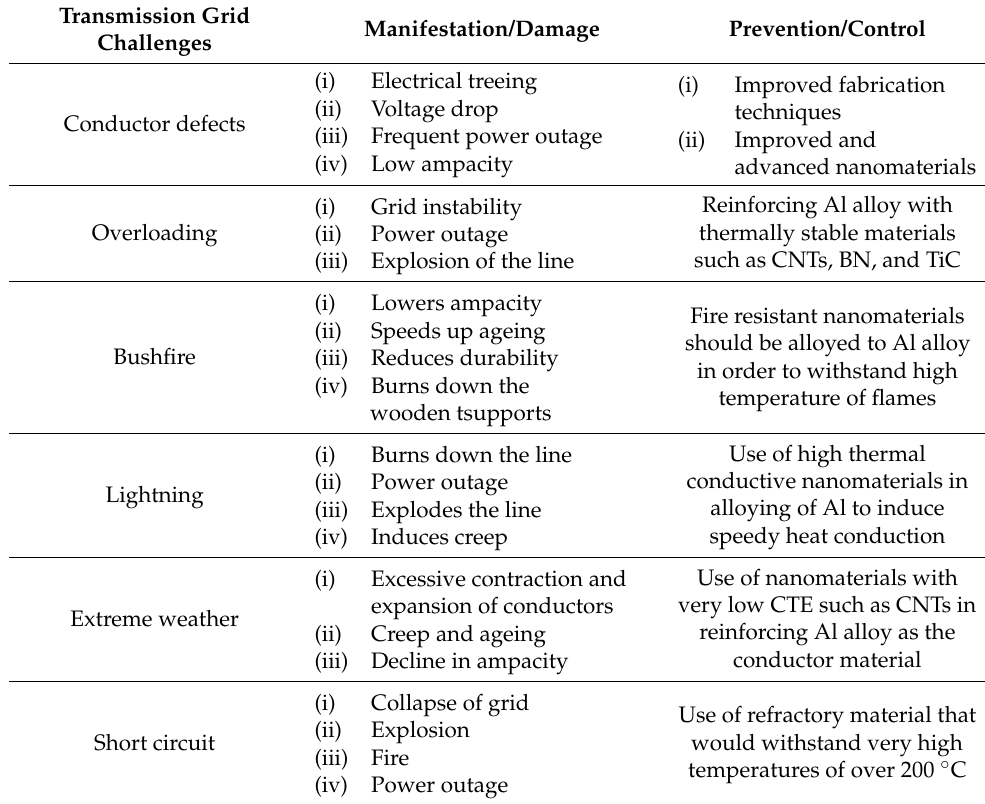
Table 3. Summary of transmission grid challenges and